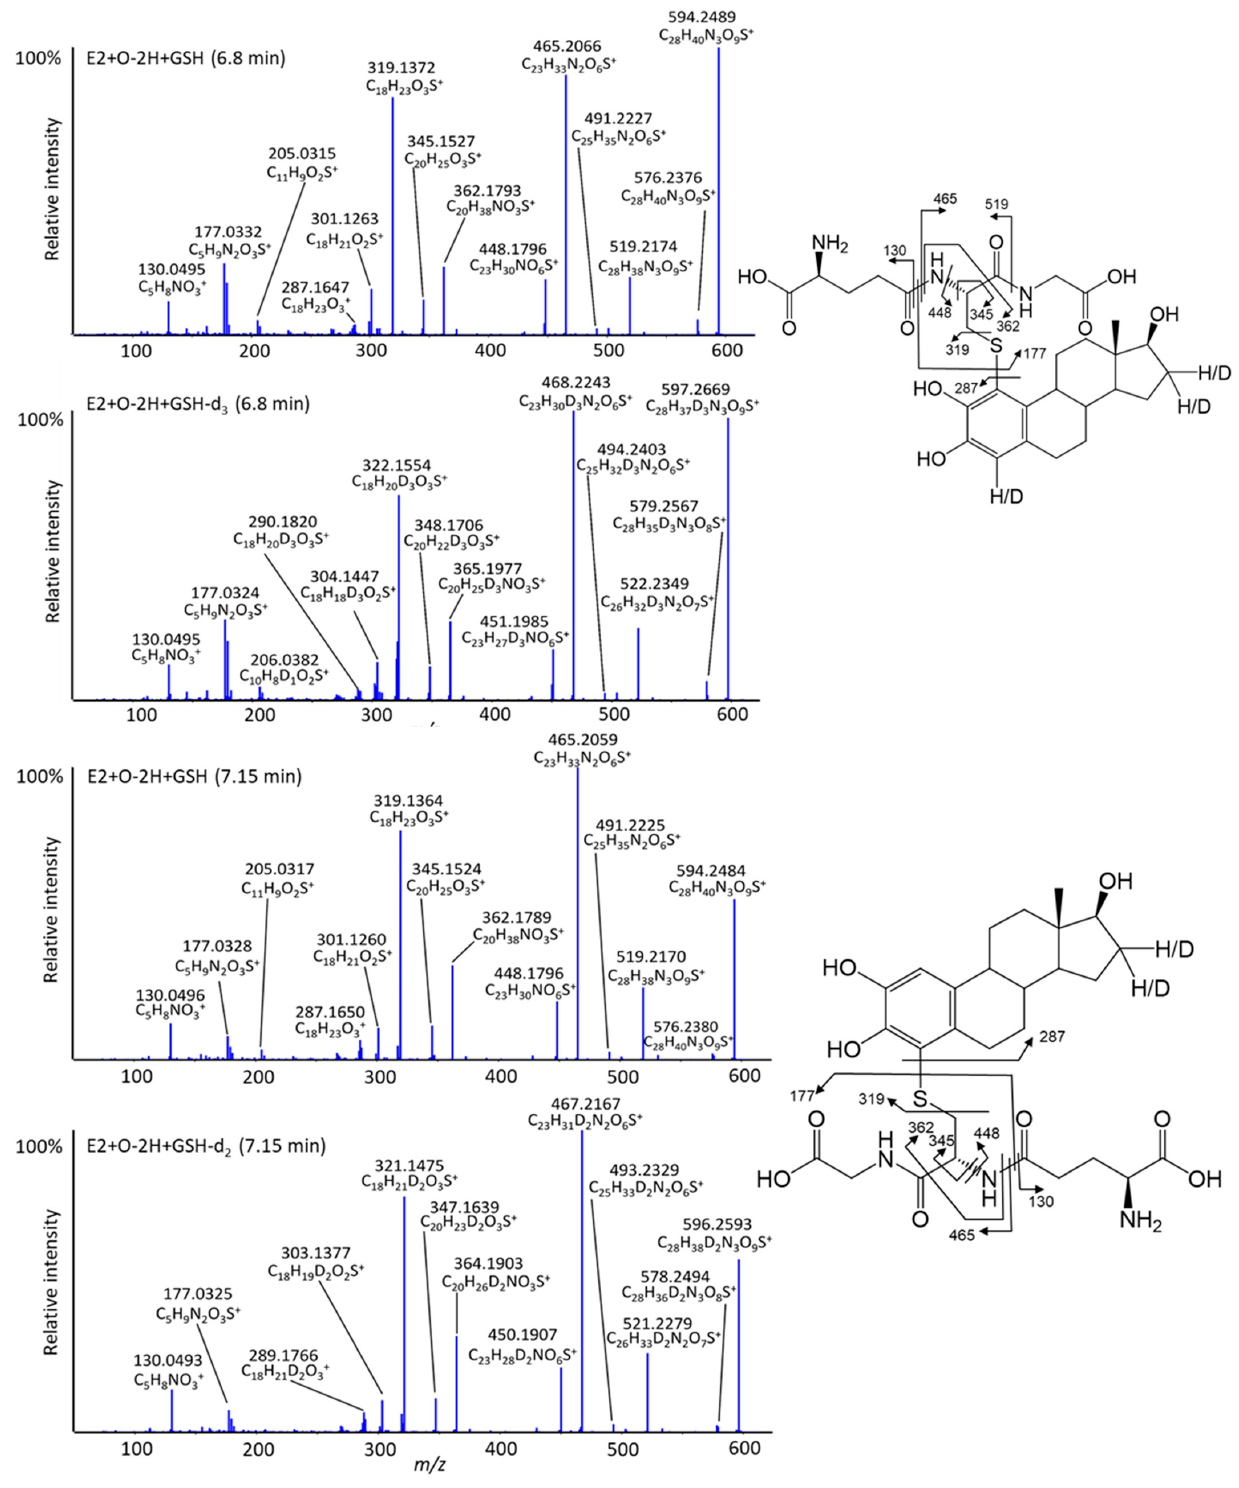
Figure 7. High-resolution MS/MS spectra of isomeric E2+O-2H+GSH adducts in their unlabeled and labeled forms, all fragment ions assigned were under 5 ppm.